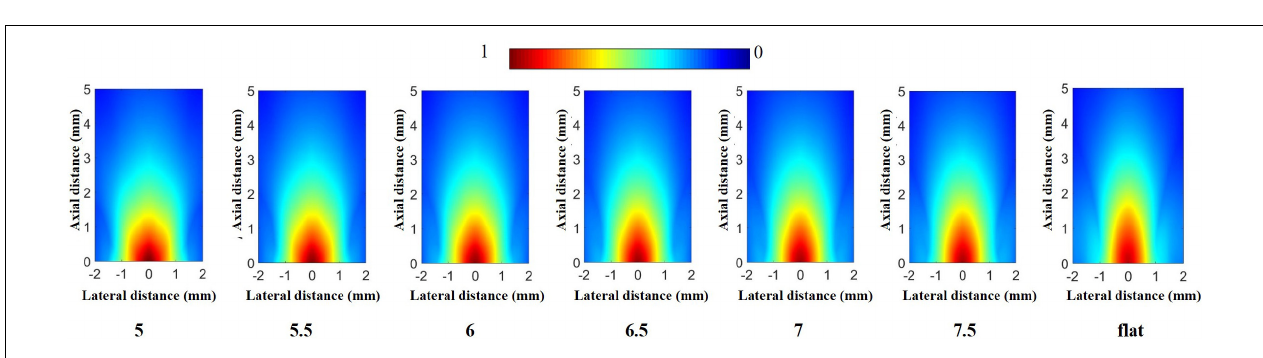
FIGURE 4 | Simulation structure: (A) The half-concave ultrasonic transducer and (B) . The plane ultrasonic transducer.